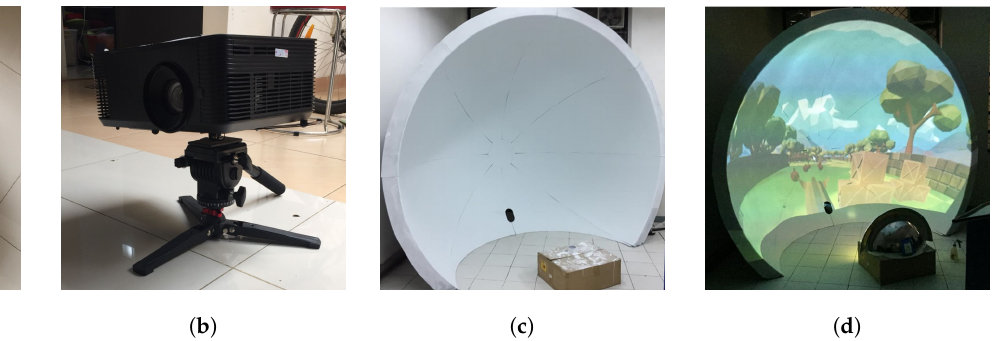
Figure 2. Dome-based VR equipment: ( a ) Spherical convex mirror, ( b ) Infocus IN3118HD LCD Projector, ( c ) iDome without projection, ( d ) iDome projecting a VR